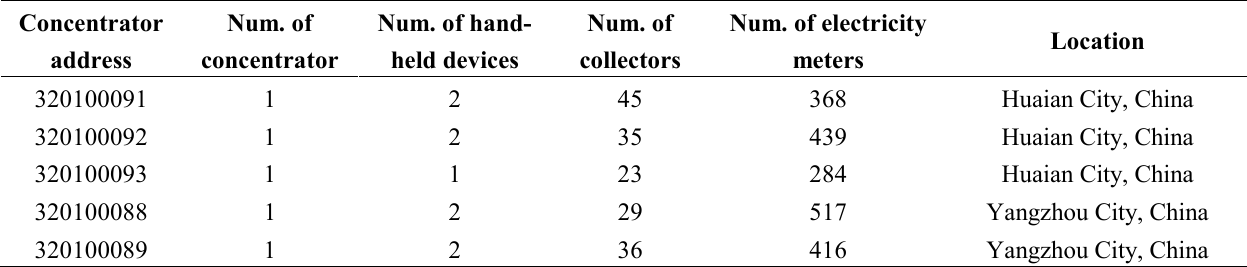
Table 4. Five EMMNets in two